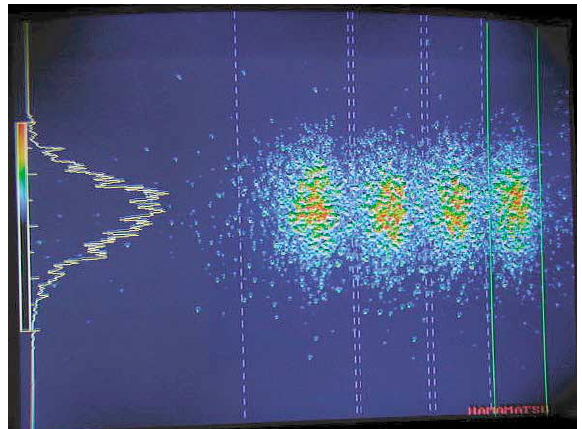
FIG. 11. (Color) A typical streak camera image of a stable train of positron bunches when the longitudinal feedback is turned on. to be measured. The measurements were made with nine trains of positrons, with four bunches per train, present in CESR. The bunch spacing in each train was 14 ns. At this bunch spacing, the instability threshold is approximately 180 mA total or 5 mA per bunch. Measurements were made at total beam current between 180 and 350 mA.